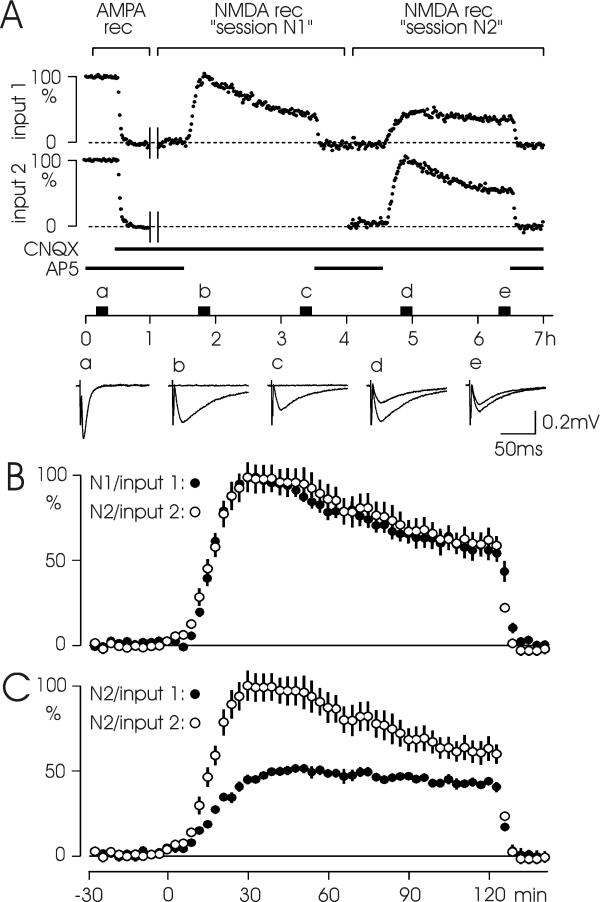
Decay of NMDA receptor mediated EPSPs in low Mg2+ solution. (A) Experimental design: Measurements of field EPSPs from a representative experiment are plotted for two independent pathways, referred to as input 1 and input 2. By appropriate use of specific blockers CNQX and AP5, either isolated AMPA EPSPs (used for initial pathway equalization) or isolated NMDA EPSPs (used in testing sessions N1 and N2) were recorded with periods of fully blocked responses in between. The pathways were stimulated alternately, each at 0.1 Hz, except for silencing input 2 for a 3 h period that contained session N1. Each point represents the average of measurements within 1 min. As seen, during N1 the responses to input 1 decayed. During session N2 both inputs were stimulated, revealing a novel decay for input 2 and occluded depression for input 1. Samples of recorded potentials of both inputs are given for the indicated time points a-e. (B) Superimposed, averaged time courses of NMDA EPSPs for input 1 during session N1, and input 2 during session N2. (C) Superimposed averaged time courses of NMDA EPSPs for input 1 and input 2, both during session N2. For B and C, each point represents the average of measurements within 3 min intervals. The peak during session N1 was used as 100 %. Values are expressed as mean ± S.E.M (n = 8 experiments).